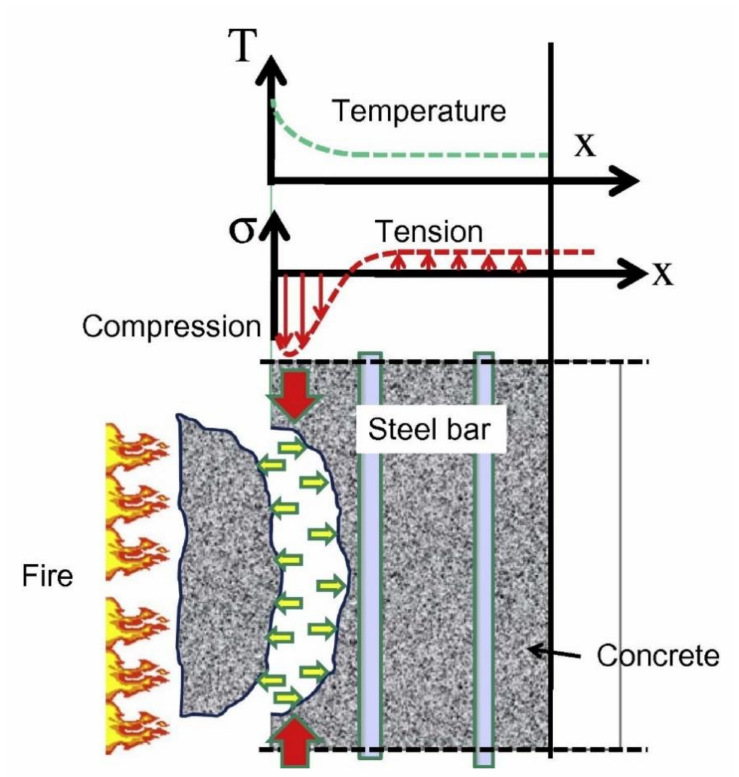
Figure 2. Mechanism of spalling of concrete due to thermal dilation